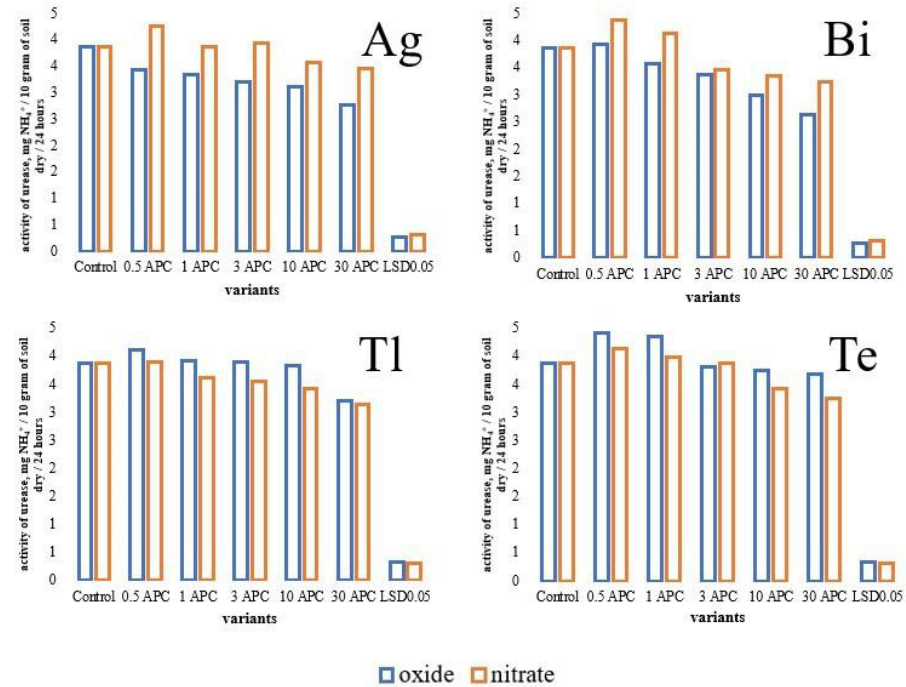
Figure 6. Changes in activity of urease in haplic chernozem under pollution with oxides and nitrates of Ag, Bi, Tl, and Te, mg NH 4+ /10 g of soil dry/24 h. of Ag, Bi, Tl, and Te, mg NH 4+ /10 g of soil dry/24 h. Only at a maximum concentration of Ag nitrate—30 APC—was the decrease in activity Only at a maximum concentration of Ag nitrate — 30 APC — was the decrease in ac- 11% relative to the tivity 11% relative to the control.